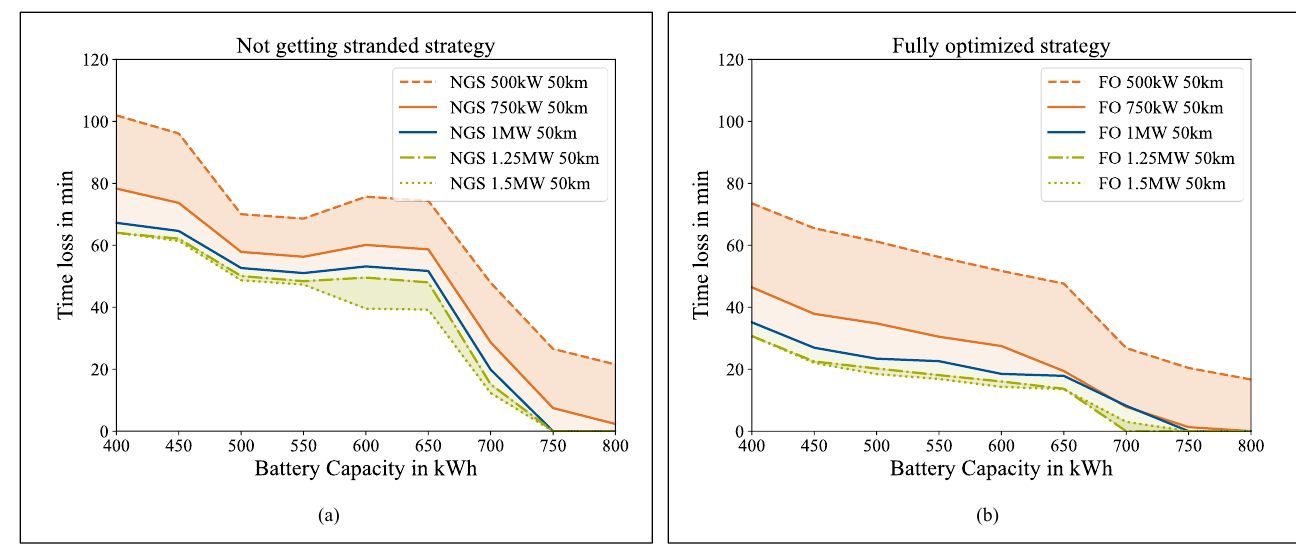
Figure 6. Influence of a varying charging power on absolute time loss using BET with ( a ) the NGS strategy and ( b ) FO strategy compared to ICET. Reducing the charging power leads to a significant increase in absolute time loss for both strategies, while increasing the charging power seems to be less beneficial.